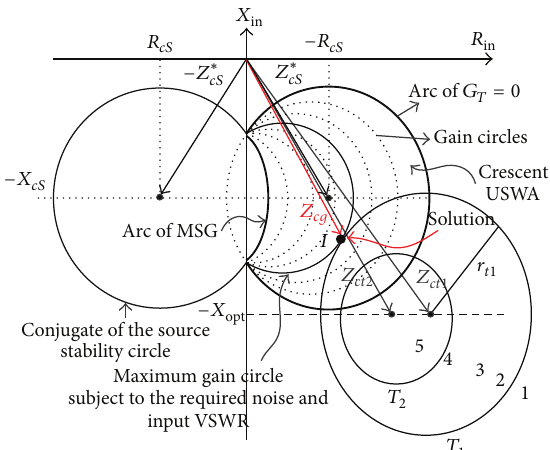
Figure 3: The crescent USWA for the conditional stability case takes place at left hand side of the 𝑍 in